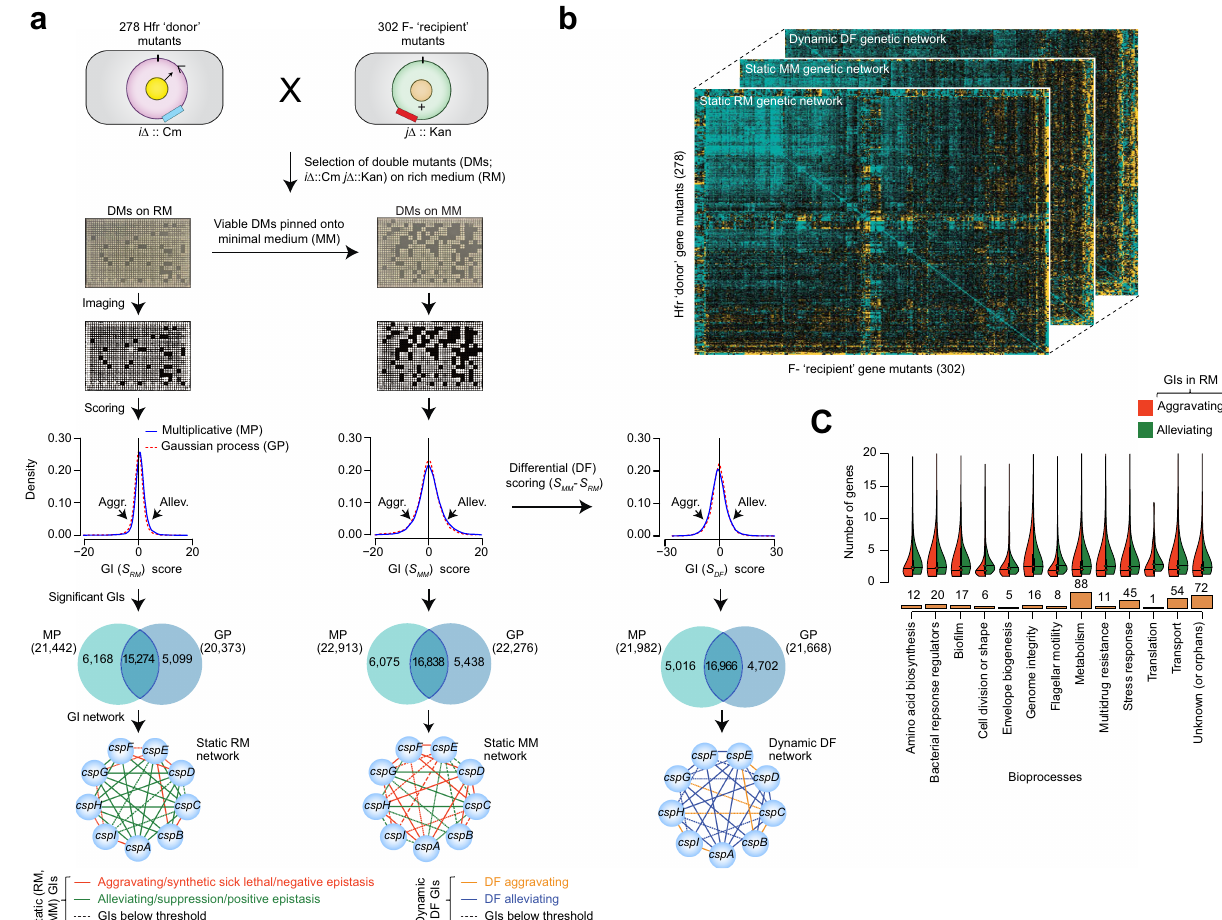
Fig. 1 TF gene targets and static and differential GI screening pipeline. a Schematic of the conjugation, double mutant generation in RM and MM growth conditions, colony imaging, mutant strain growth rate measurements ( n = 8 replicate gene pairs per donor) using multiplicative and Gaussian process models, and construction of static and differential genetic networks using the signi fi cant GI scores derived from respective growth conditions. b , c TF genes screened as donors and recipients ( b ) to generate static and differential networks, and their assignment ( c ) into 13 broadly representative bioprocesses. Source Data are provided as a Source Data fi